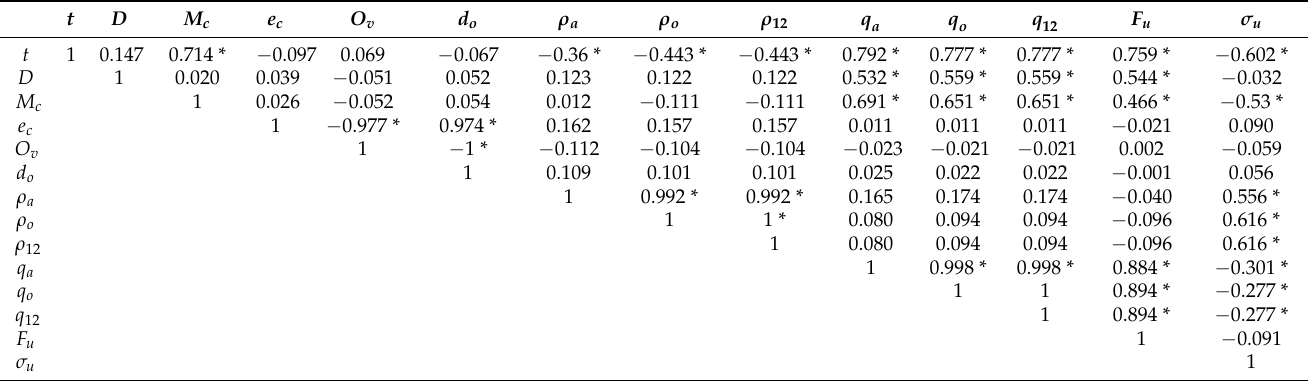
Table 3. The Pearson correlation matrix